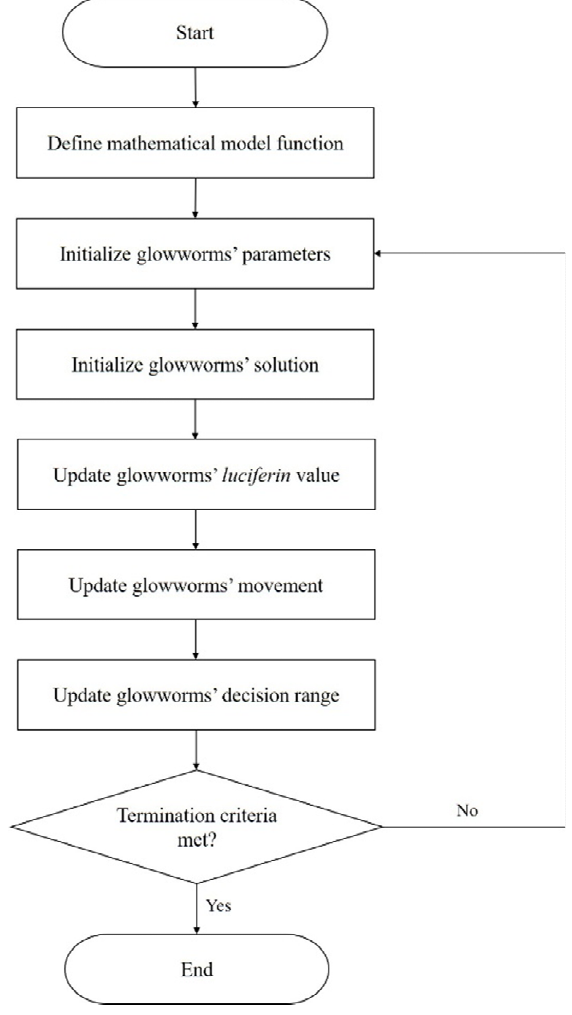
Figure 6. Flowcharts of GSO process implemented by Hanid et al. [34], adapted from [34].